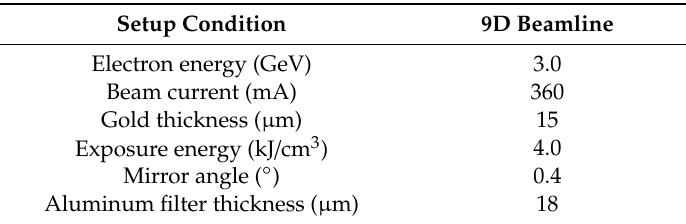
Table 1. Experimental setup condition of the 9D